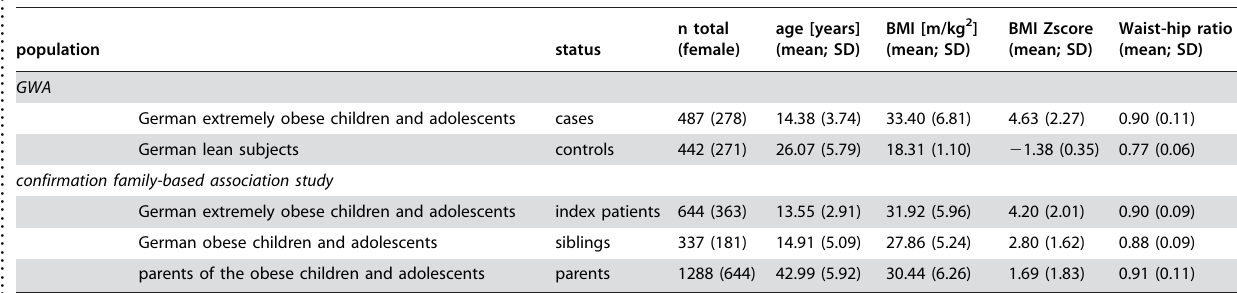
Table 2. Description of samples genotyped with the Genome-Wide Human SNP Array 5.0 and the obesity families used